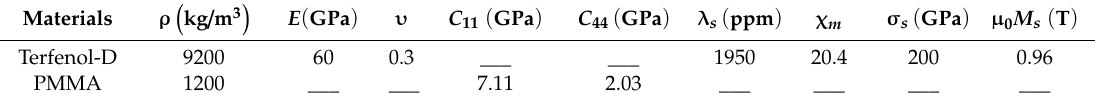
Table 1. Material parameters of Terfenol-D [36] and polymethyl methacrylate (PMMA) [37].